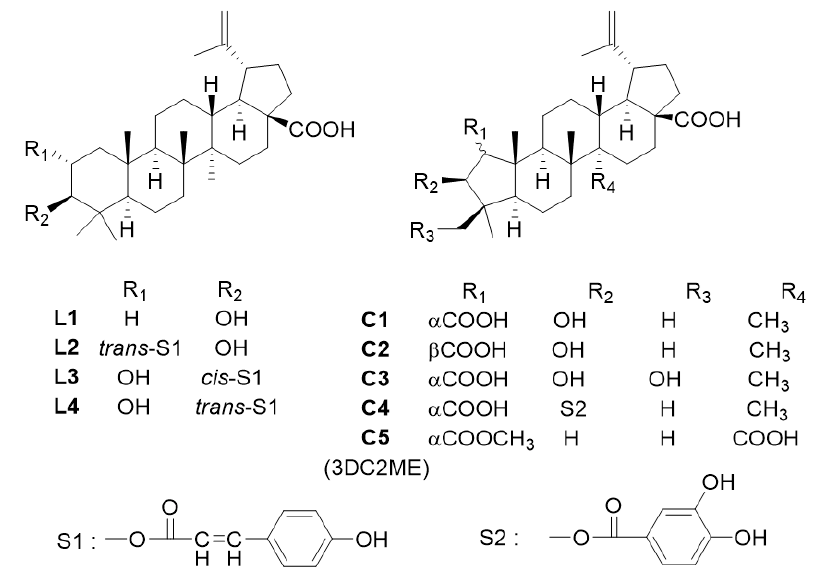
Figure 9. The chemical structures of four lupane-type (L1–L4) and five ceanothane-type (C1–C5) triterpenoids isolated from Z. jujuba .